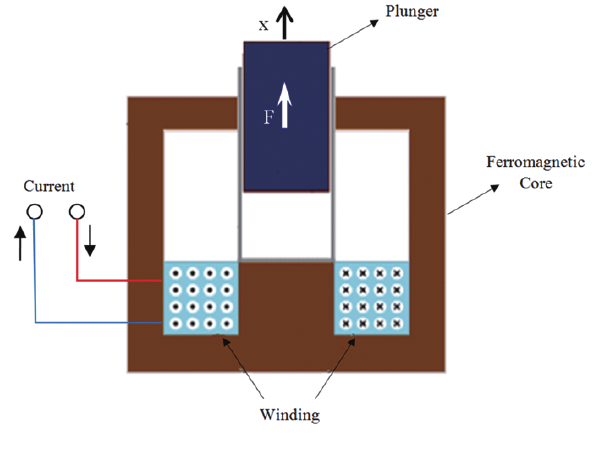
Fig. 11. Linear solenoid actuator schematic.